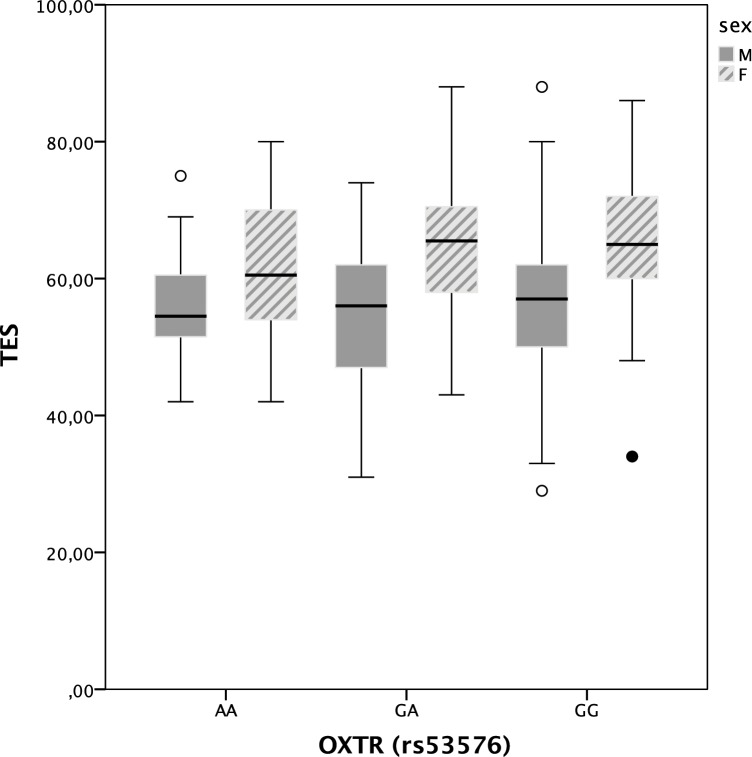
Trait empathy score (TES) across genotypes by sex.Male sex is indicated by dark grey solid boxes, female sex by light grey patterned boxes. Boxes represent the 25th percentile, the median and the 75th percentile. Whiskers represent the minima and maxima of TES scores excluding outliers.